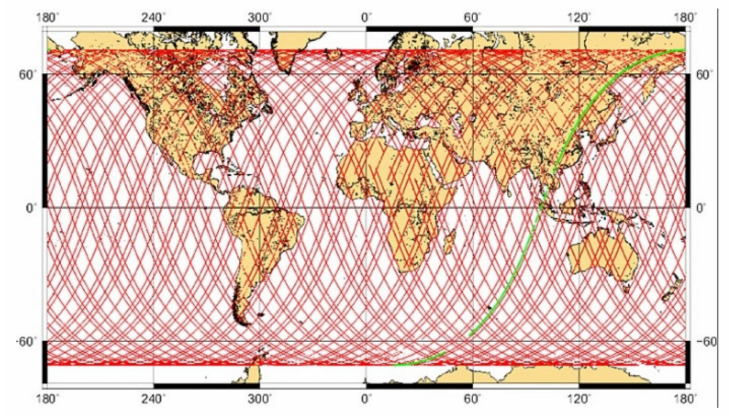
Figure 1. Scheme of tracks of the satellite that measures the sea-level